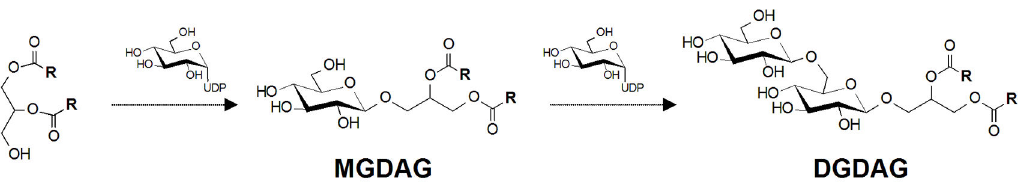
Figure 1. Reaction catalyzed by Mycoplasma genitalium GT MG517. It is a membrane-associated sequentially-acting GT activated by anionic